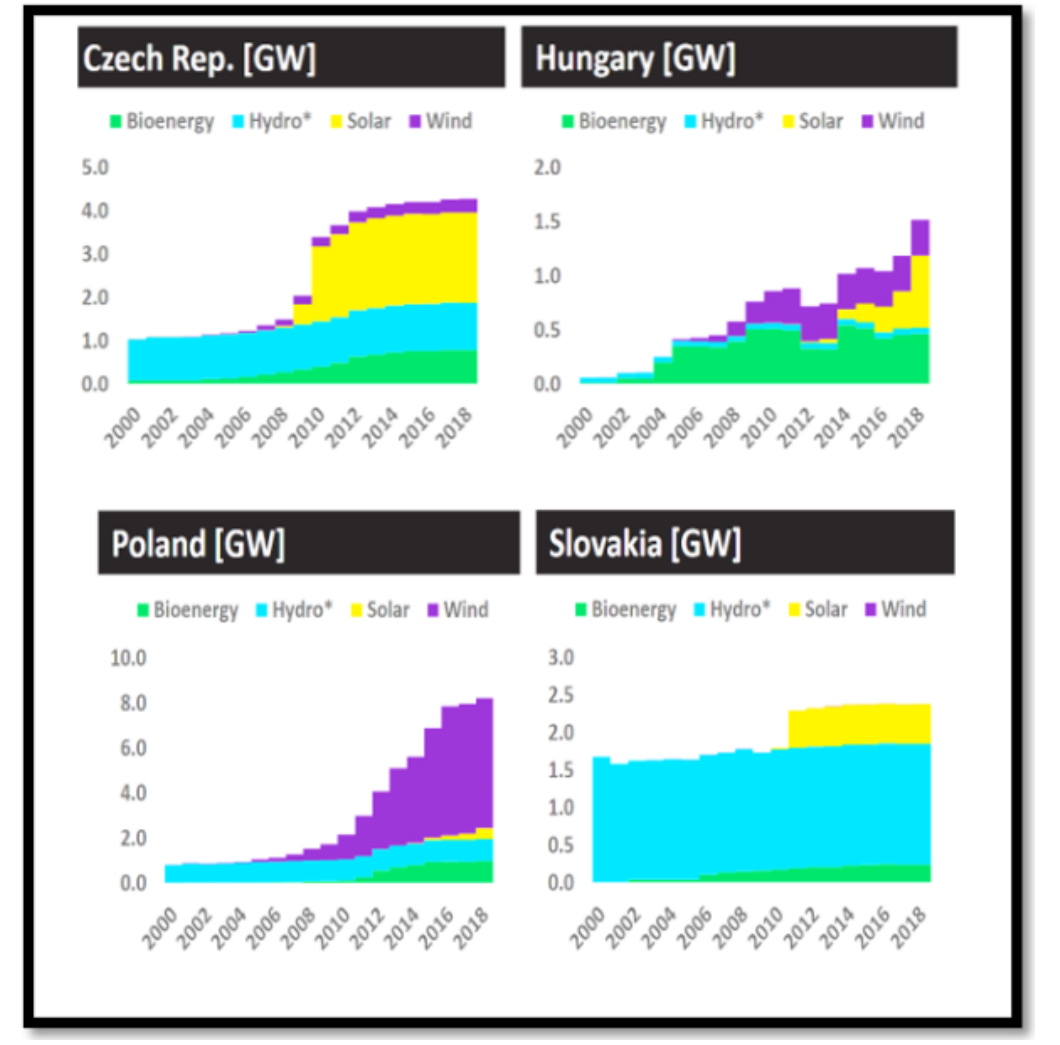
Figure 1. Development of renewable sources of energy (RES) by installed power in V4 countries, as of 2019. Adapted from [47].